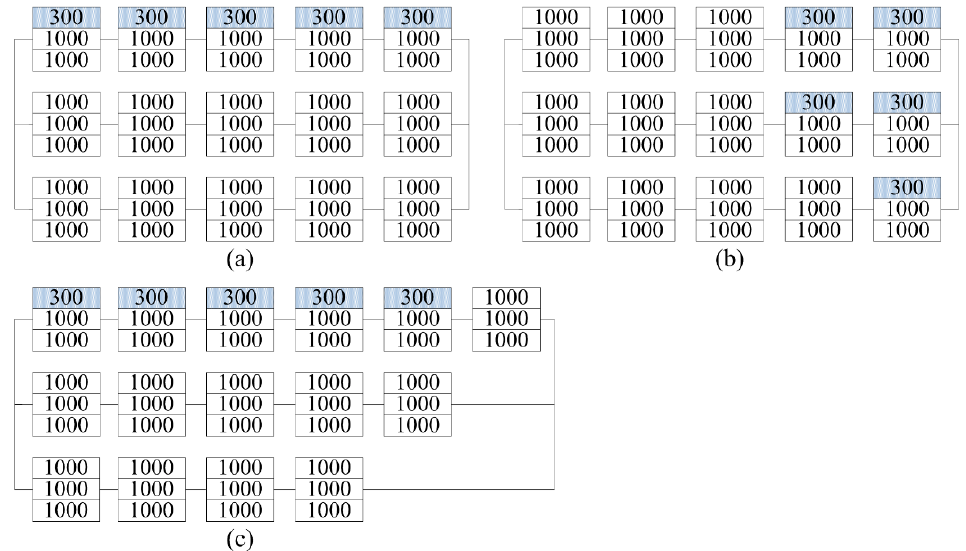
Figure 17. ( a ) Primary configuration C ori ; ( b ) optimized configuration C EMPP ; and ( c ) optimized configuration C opt .